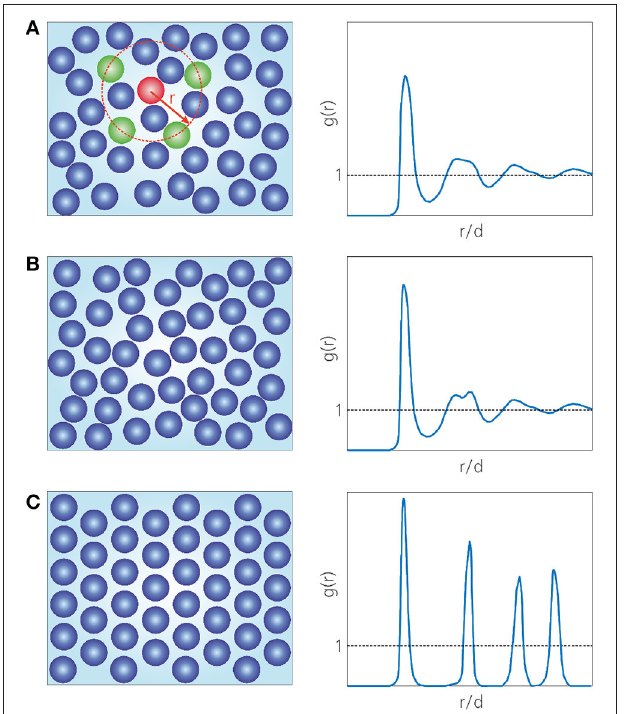
FIGURE 1 | Schematic picture of the structure of (A) a normal liquid, (B) an amorphous solid, i.e., a glass, and (C) a crystalline solid. The first panel highlights four (green) particles which are separated by a distance r from a (red) reference particle. The right panels illustrate the corresponding radial distribution functions g ( r ), which describe the probability of finding a particle a distance r away from any reference particle, relative to the ideal-gas case. The first peak in g ( r ) represents the first solvation shell at r ≈ 1 d , where d is the particle diameter. The dashed black lines indicate the ideal-gas result g ( r ) = 1.